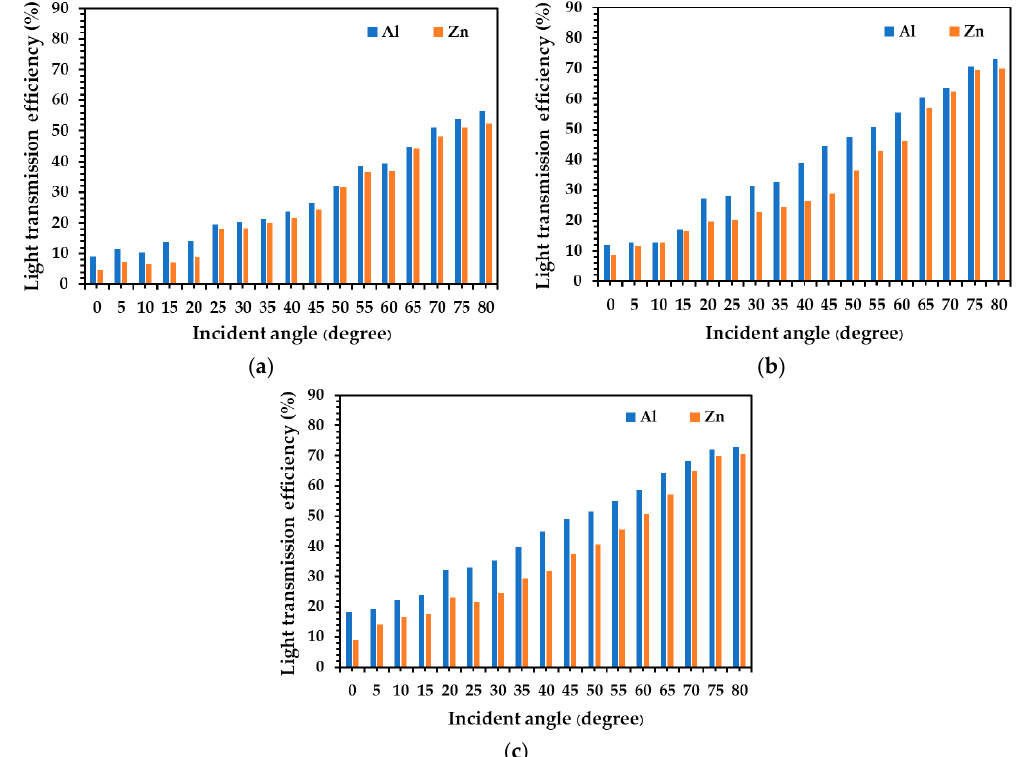
Figure 11. Light transmission performance of light tubes with different materials with diameters of ( a ) 0.20 m, ( b ) 0.25 m, and ( c ) 0.30